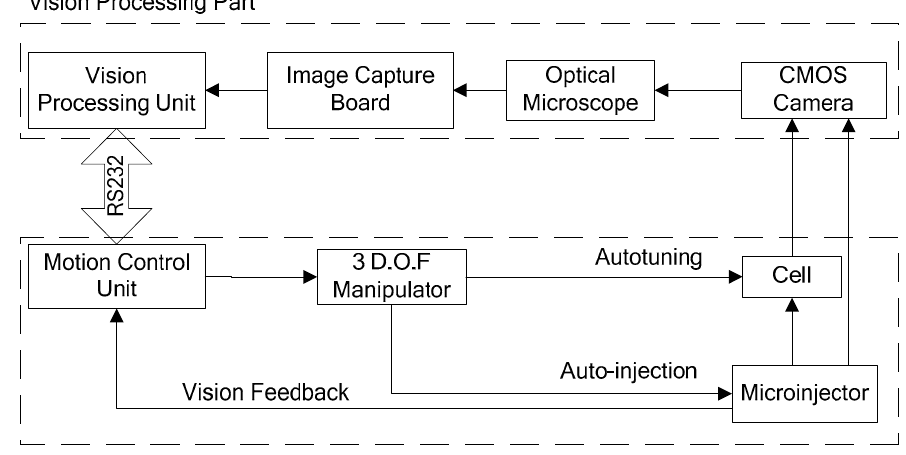
Figure 1. Block diagram of the automatic cell microinjection system.